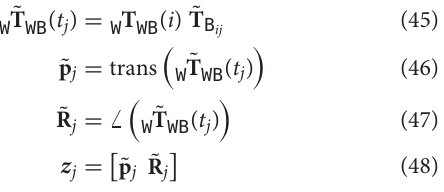
FIGURE 4 | Pre-filtering and Outlier filtering. (A) Raw point cloud from Valkyrie’s dataset; people are outlined in red. (B) After pre-filtering; people and small irrelevant features have been filtered out. (C) Region of overlap as the result of the analysis of the volumes of the two point clouds.